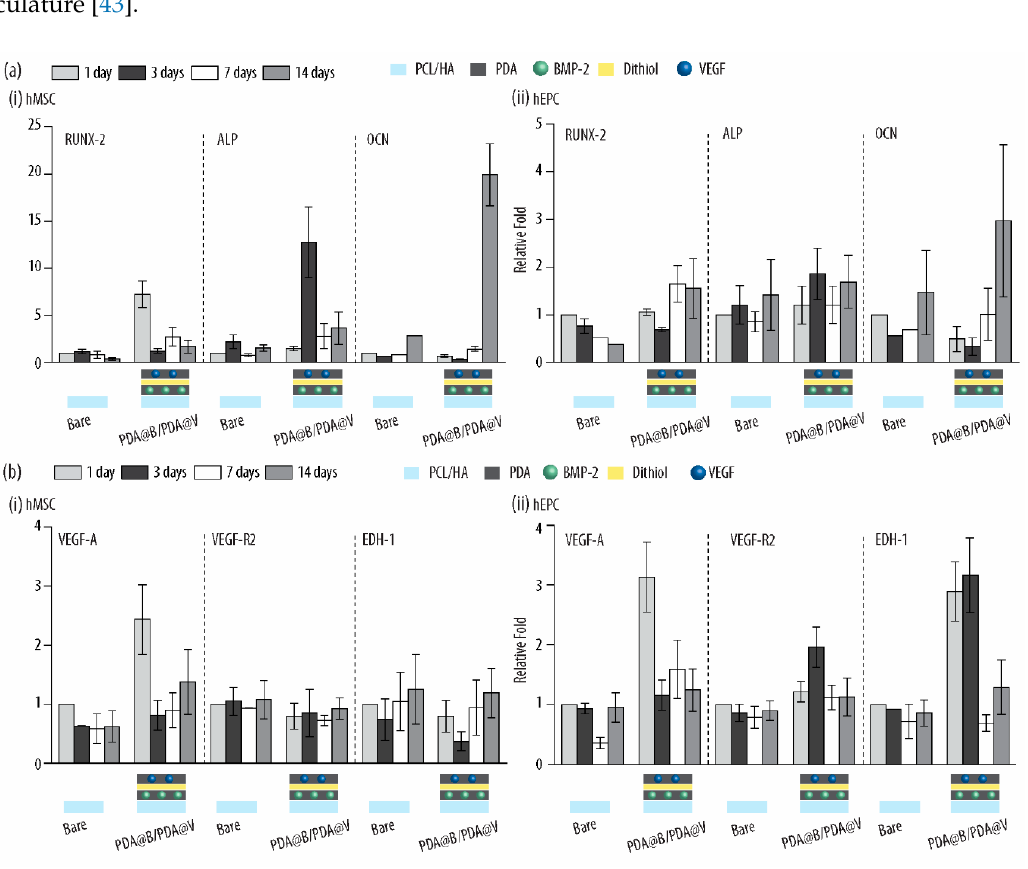
Figure 4. Real-Time quantitative reverse transcription polymerase chain reaction (qRT-PCR)